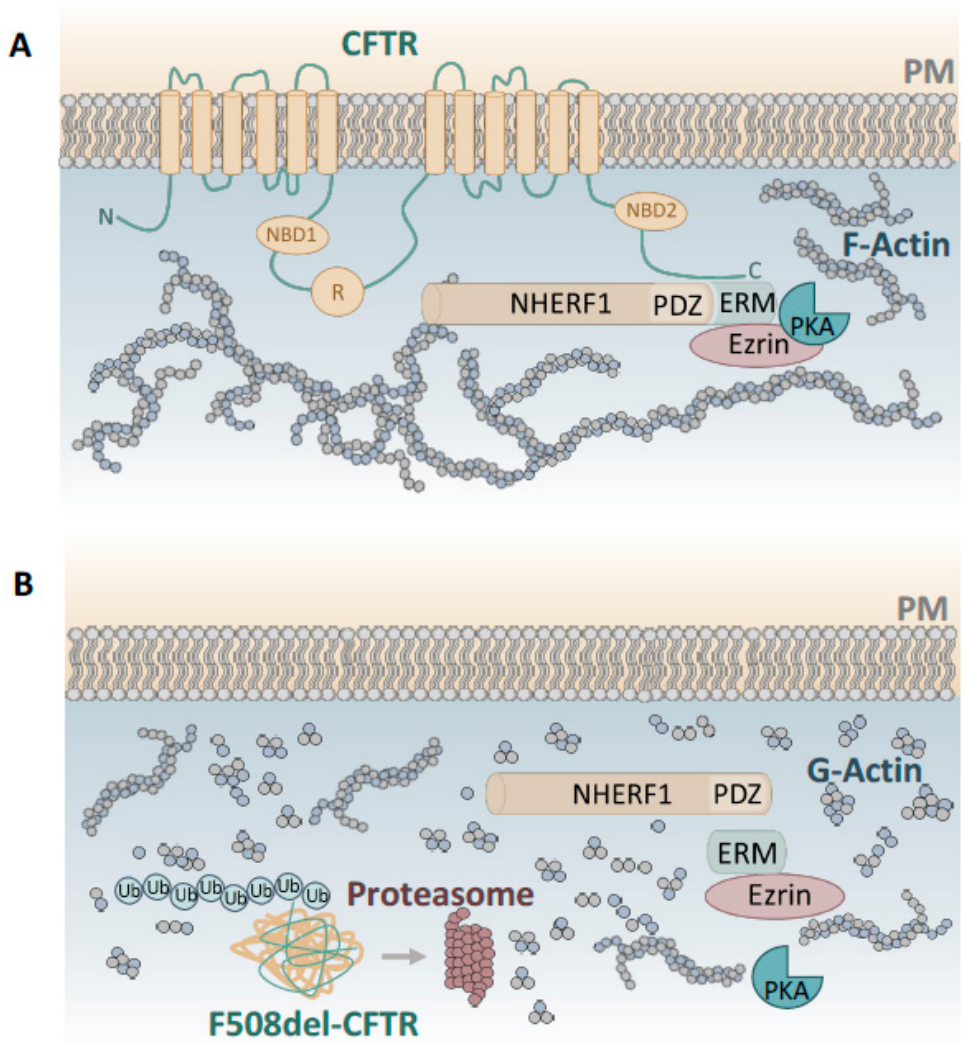
Figure 1. CFTR and its connections to the actin cytoskeleton. ( A ) In normal epithelial cells CFTR is expressed at the apical plasma membrane (PM) and promotes the polymerization of actin monomers needed to establish a well-organized actin cytoskeleton. ( B ) In CF cells, the actin cytoskeleton is less organized due to dysfunctional CFTR, which is not transported to the apical PM, but targeted for degradation. Adapted from [23].